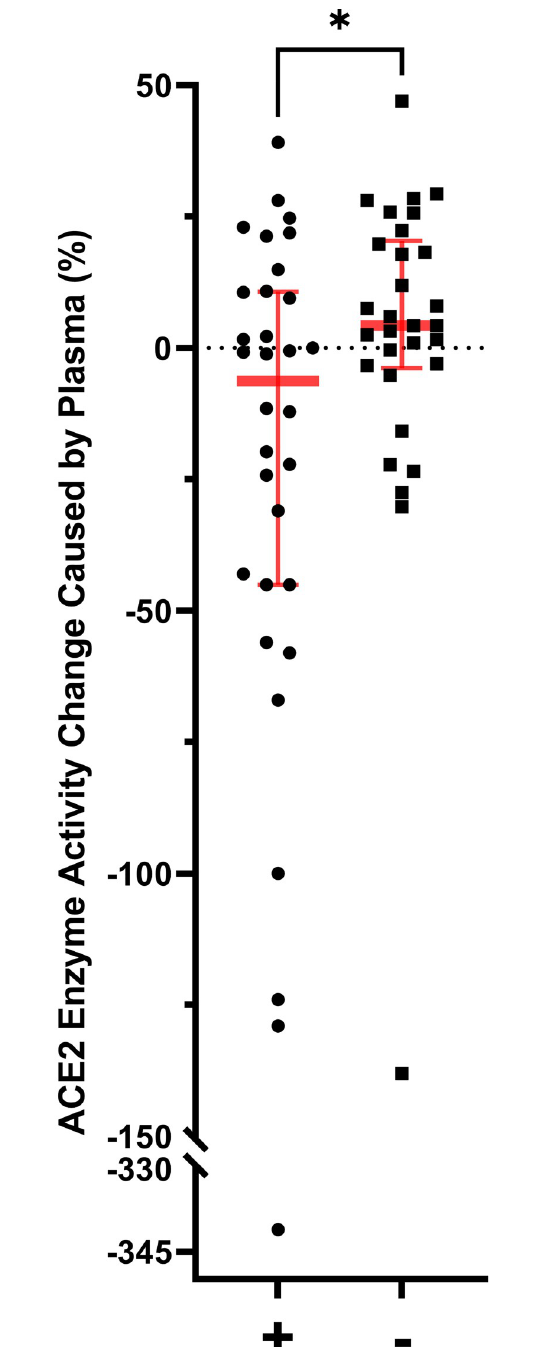
Fig 5. Change in activity of exogenous ACE2 after addition of plasma from patients that had ACE2 antibodies in plasma (+) compared to those that did not (-). Plasma from patients with an ACE2 antibody present decreased ACE2 activity. Bars show mean values and error bars show standard error of the mean ( ��� p <